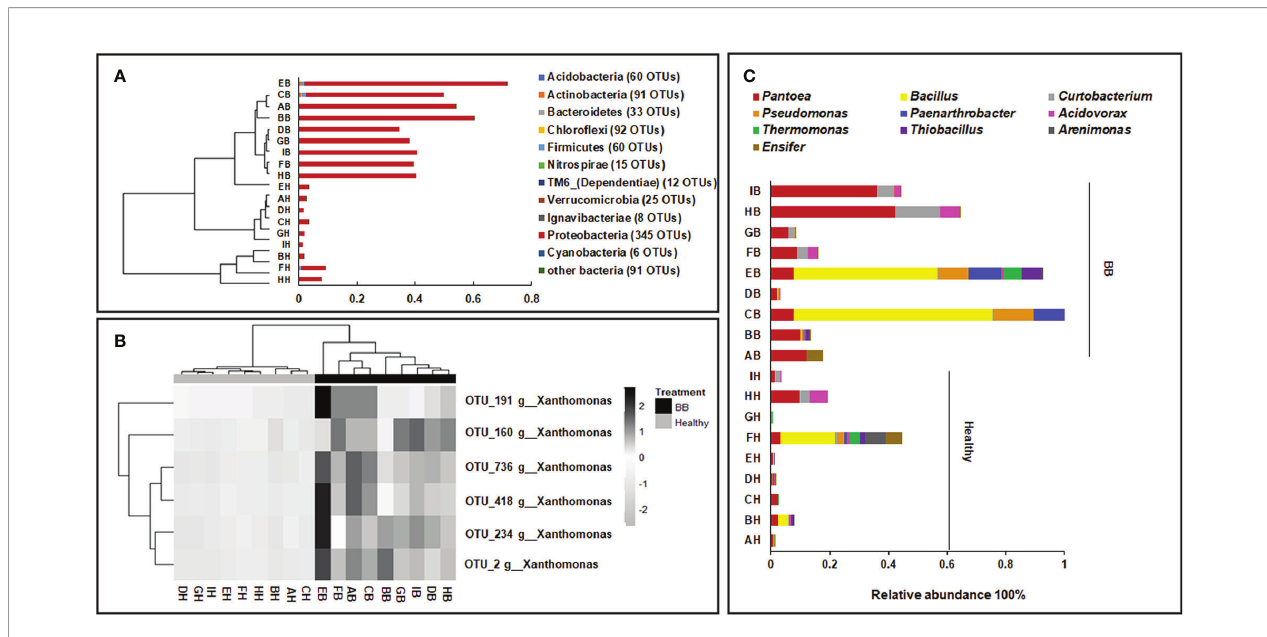
FIGURE 1 | Compositional structure of the endophytic bacterial communities of rice leaves. (A) The hierarchical clustering of samples based on the relative abundance of dominant bacterial phyla; (B) The abundance of the Xanthomonas OTUs in BB-diseased and healthy leaves; (C) The relative abundance of the dominant bacterial genera recovered from BB-diseased or healthy leaves. AH-IH, healthy leaves of rice cultivars; AB-IB, BB leaves of rice cultivars used in this